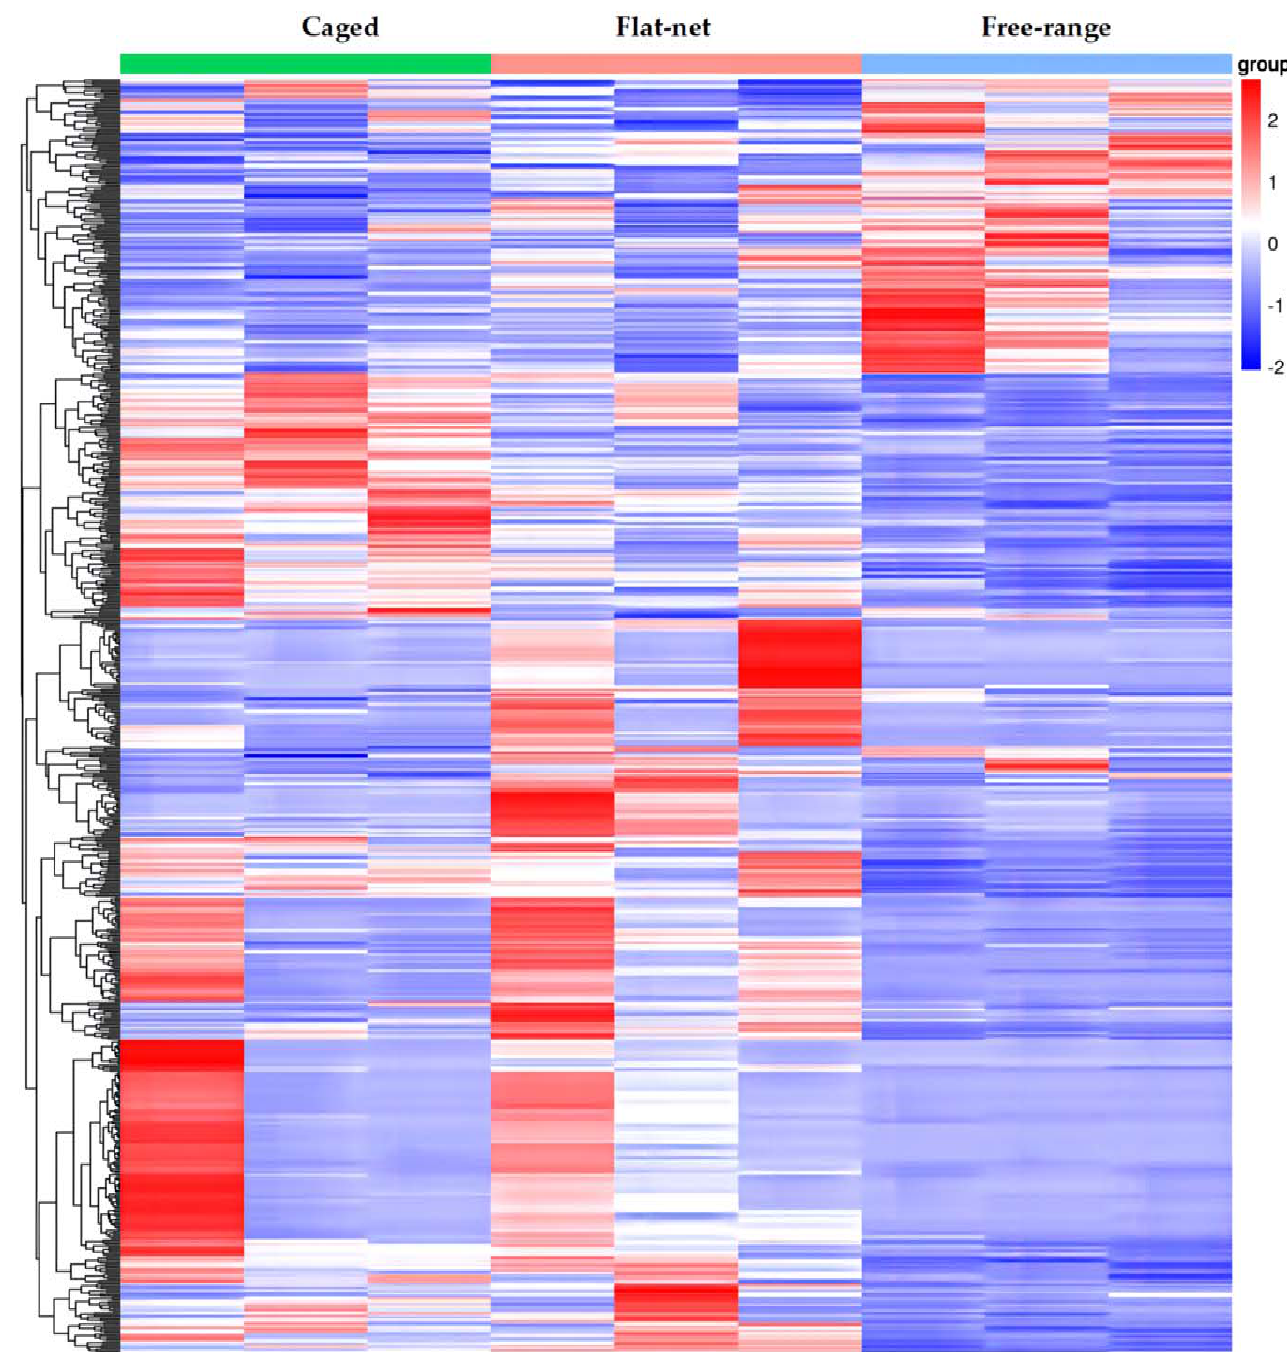
Figure 1. Gene expression clustering heat map under three rearing systems. Each column in the heat map represents the expression of different genes in the same sample, and each row represents the expression of the same gene in different samples. Red genes are up-regulated, and blue genes are down-regulated in the affected